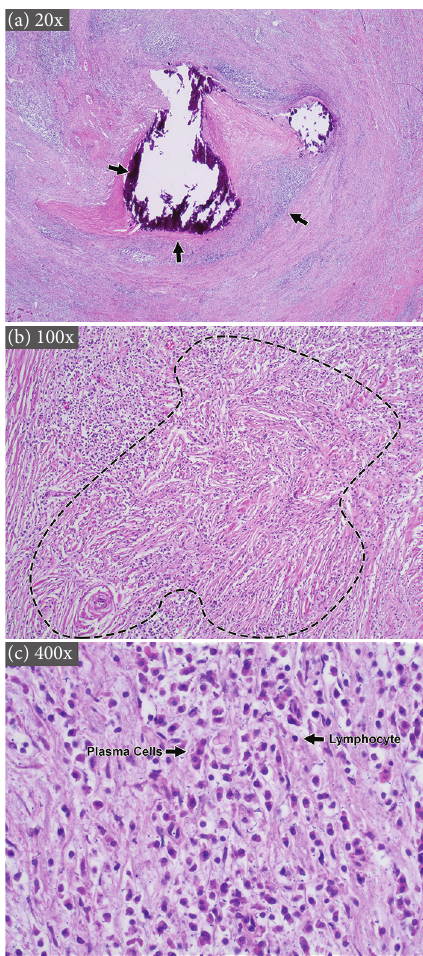
Figure 1: Histology of coronary artery from the patient described in this case report. (a) Low-power magnification of coronary artery demonstrating inflammatory infiltrate, hyalinization, and calcifi- cation (marked by arrows in clockwise fashion, respectively) (hemotoxylin and eosin (H&E), 20x). (b) High-power magnifi- cation demonstrating a storiform pattern of fibrosis, enclosed within the dashed line (H&E, 100x). (c) High-power magnification demonstrating lymphoplasmacytic nature of inflammation with arrows indicating representative plasma cells and lymphocytes (H&E,